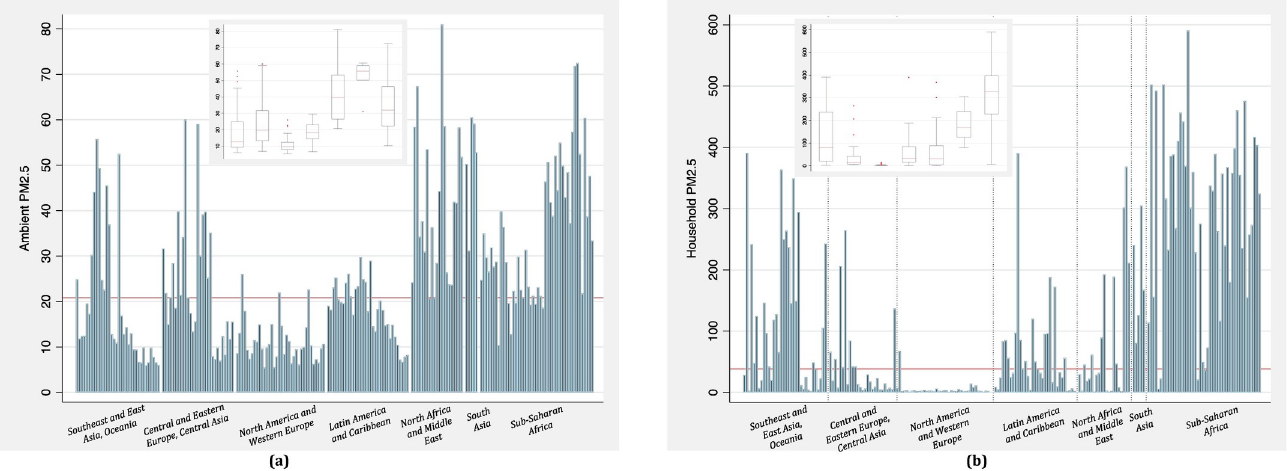
Fig 1. The annual average ambient (a) and household (b) PM 2.5 concentrations ( μ g/m 3 ) in 204 countries and territories for 2019. The box plots in the inset show the super regional distributions. Note: The red horizontal line in the overall plots represent the global median, and those within the boxes are the GBD 2019 super regional medians. The boxplots are arranged in the same order as the super regions in the overall plot. GBD, Global Burden of Disease, Injuries, and Risk Factors; PM 2.5 , particulate matter < 2.5